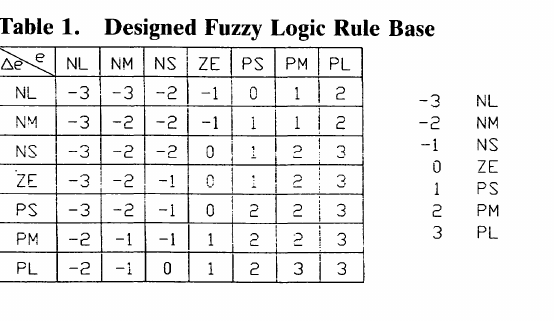
Table 1. Designed Fuzzy Logic Rule Base